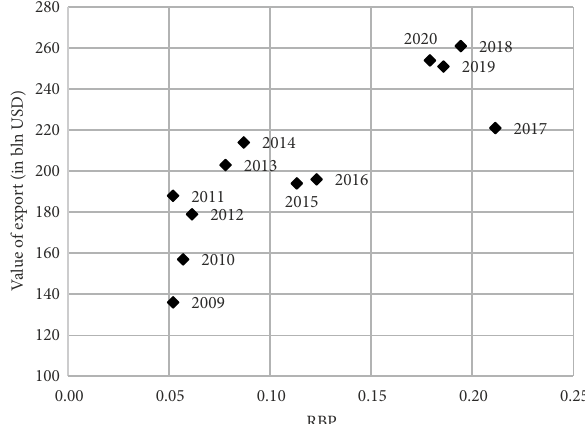
Figure 6. Regional Barometer of Protectionism for Poland versus Polish export between 2009 and 2020 (source: authors’ own calculations,